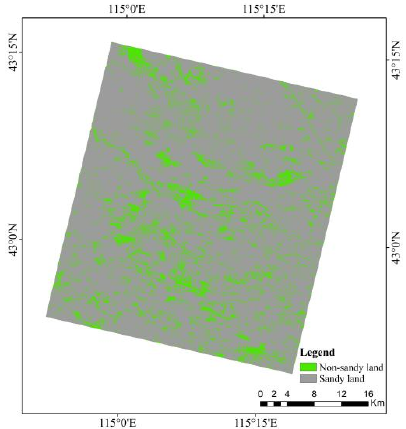
Figure 9. Sandy land detection based on feature-level fusion.